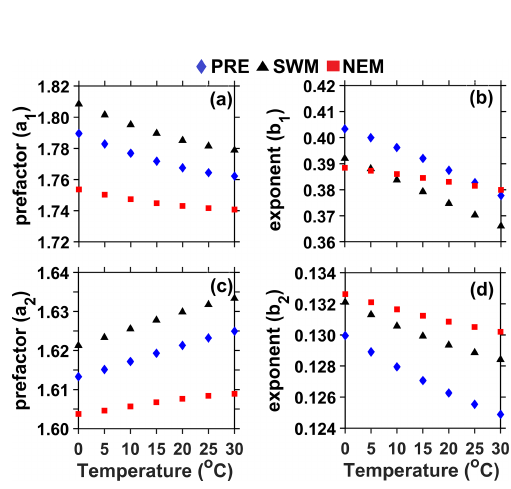
Figure 5. Temperature dependency of coefficients of DSD param- eter relations in different seasons. (a, b) Variation of a 1 and b 1 in Eq. (6) with temperature in different seasons. (c, d) Same as (a) and (b) but for Eq.